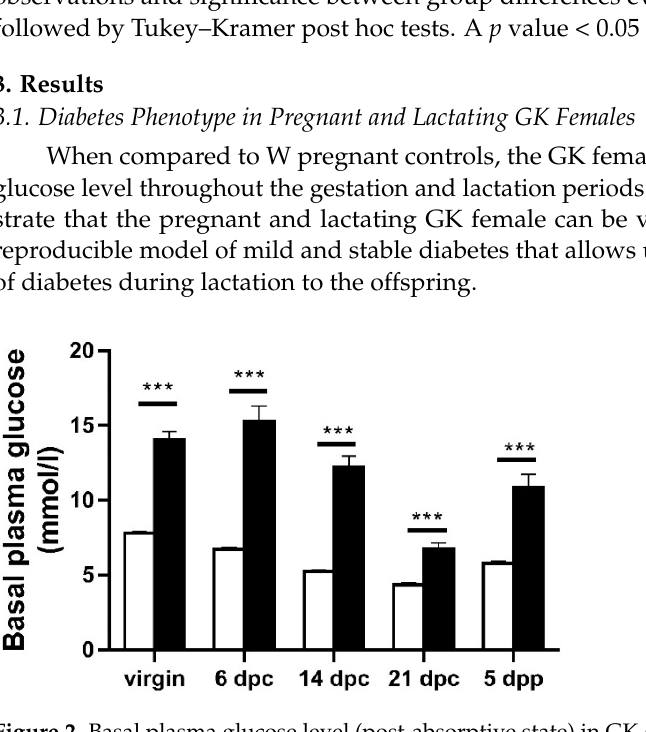
Figure 2. Basal plasma glucose level (post-absorptive state) in GK (black bars) and Wistar rat (white bars) females before pregnancy (virgin), during pregnancy on days 6, 14 and 21 (day post-coitum, dpc) and during lactation on day 5 after delivery (day postpartum, dpp). Duration of pregnancy was the same in both groups (21.5 days). Values are mean ± SEM. Nine to twelve rats were analyzed per experimental group. *** p < 0.001 as compared to age-related value in the W group.